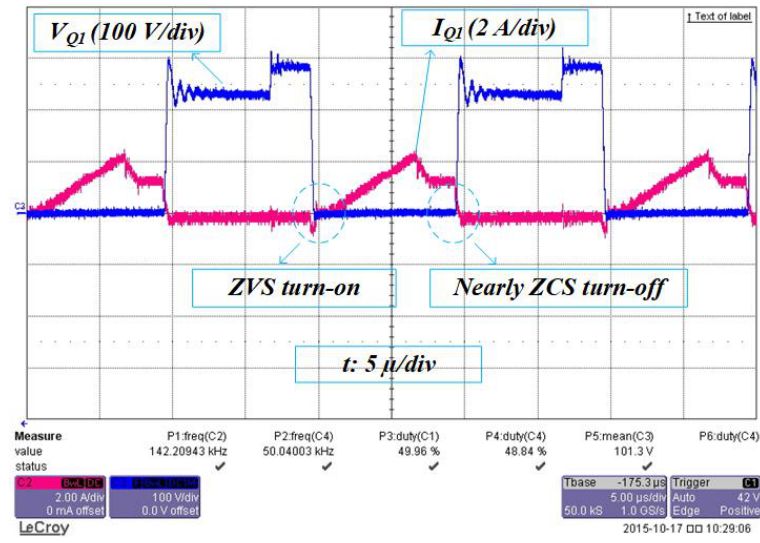
Figure 12. Voltage and current of switch Q 1 at 10% of load.